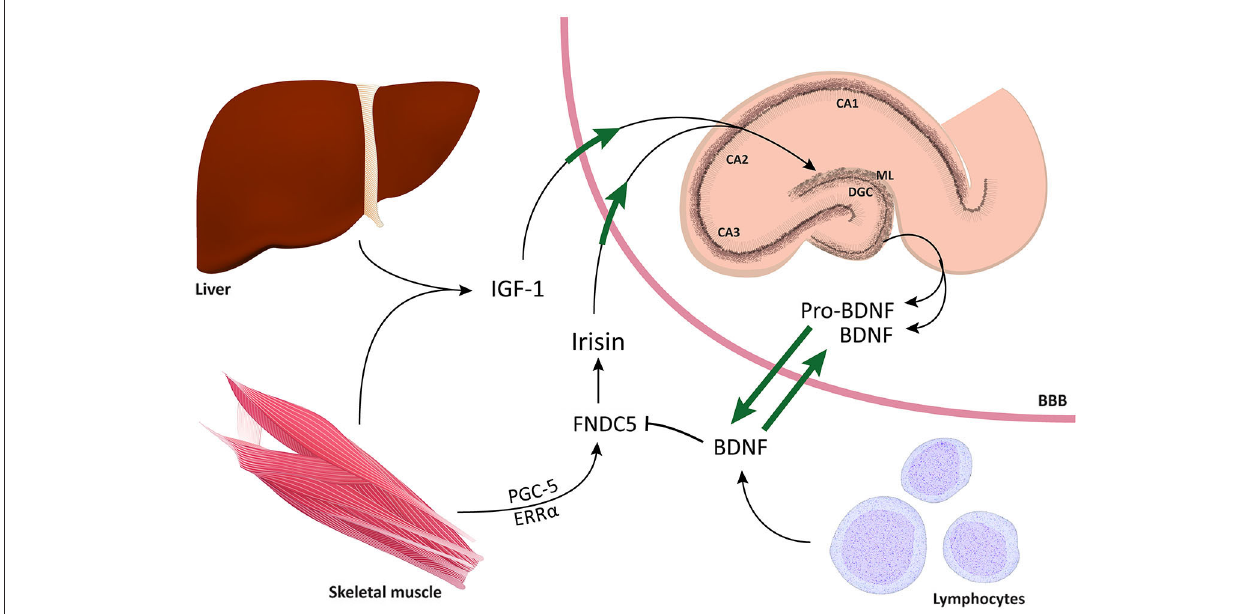
found in the spinal cord, DRGs, muscles, intestines, and kidneys suggests that BDNF can exert multiple regulatory effects on both sides of the BBB. Through co-activation of PGC1 α and ERR α , physical activity induces the production of FNCD5. Following cleavage by a protease, FNDC5 is cleaved into irisin, which has the ability to cross the BBB and induce BDNF gene expression in the hippocampus. Notably, it has also been shown that high concentrations of IGF-1 are released by the liver and can, in turn, improve neurogenesis in the DG and induce BDNF gene